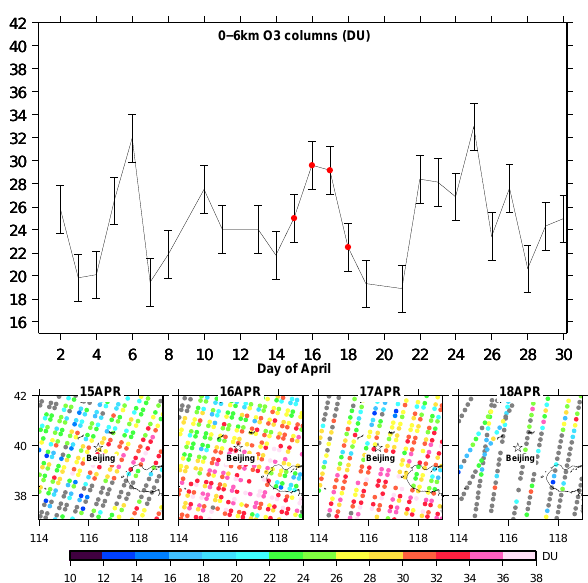
Figure 15. Same as Fig. 12 for the period from April 15 th to April 18 th . Fig. 15. Same as Fig. 12 for the period from 15 to 18